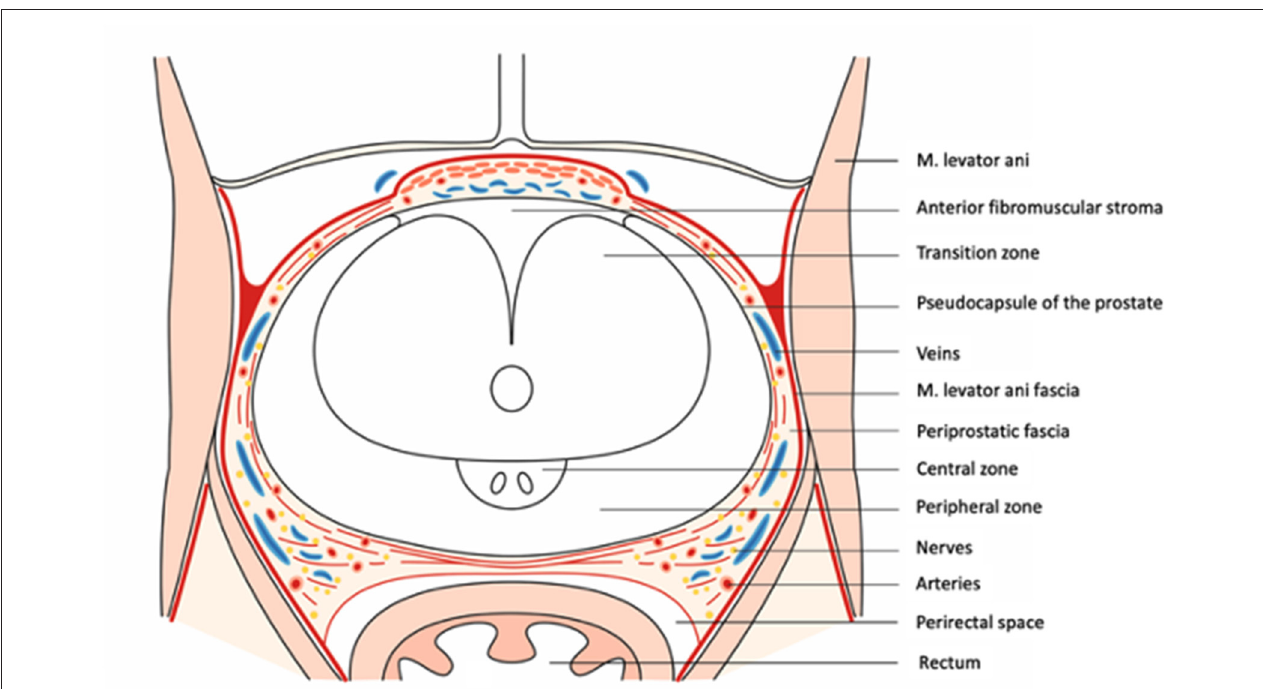
FIGURE 2 | Axial section of the prostate and its adjactent tissue at